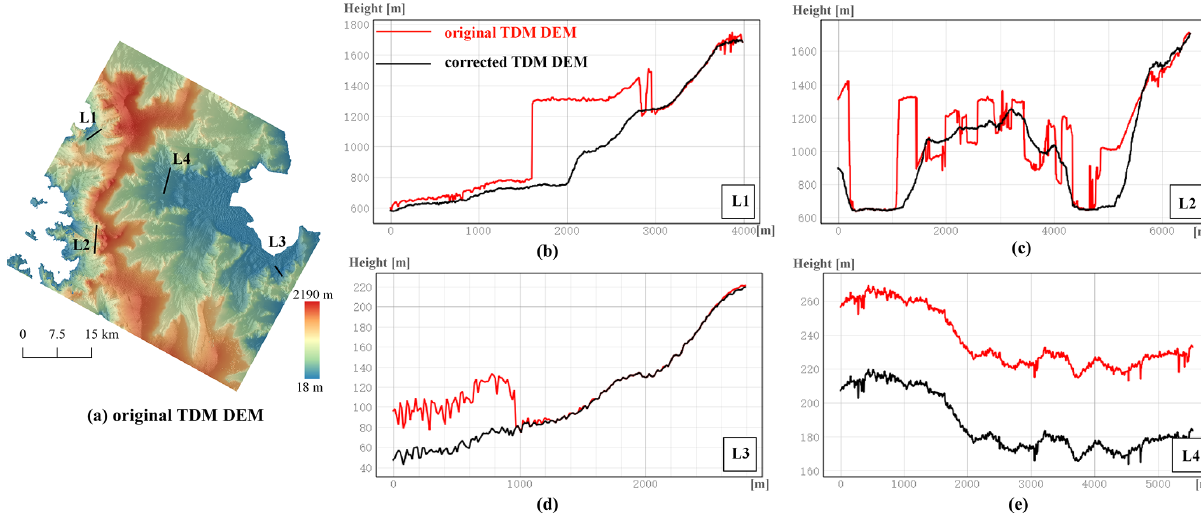
Figure 10. Four elevation profiles extracted along lines L1–L4 from the original and corrected TDM DEM in the HG area.